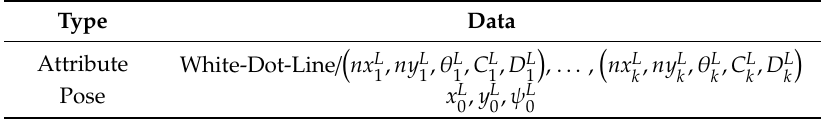
Table 3. Example of a road line as the time-invariant object.